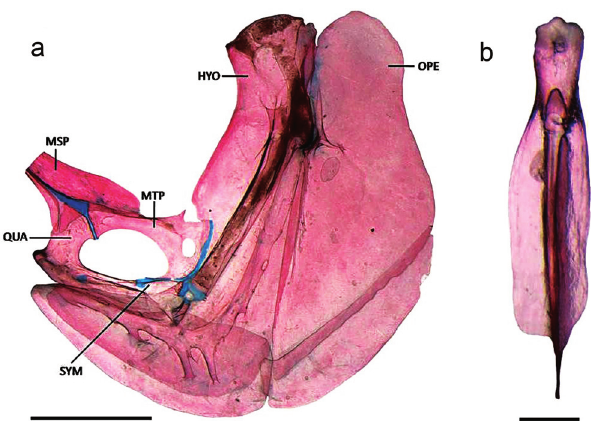
Fig. 4. Suspensorium, lateral view (a) and of the urohyal, dorsal view (b) of Probolodus heterostomus , LIRP 6296, 70.7 mm SL. HYO: hyomandibula, MSP: mesopterygoid,